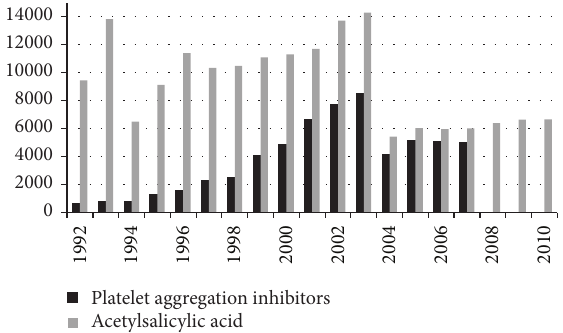
Figure 1: Drug prescribing: platelet aggregation inhibitor according to the German Rote Liste and generic drug: acetylsalicylic acid prescribed at the expense of the statutory health insurance funds [3].